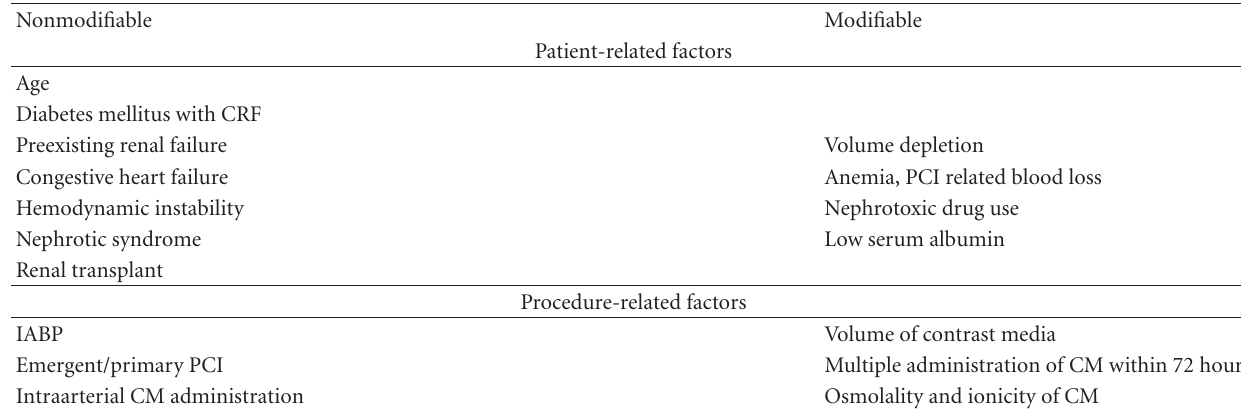
Table 1: Risk factors for development of contrast-induced